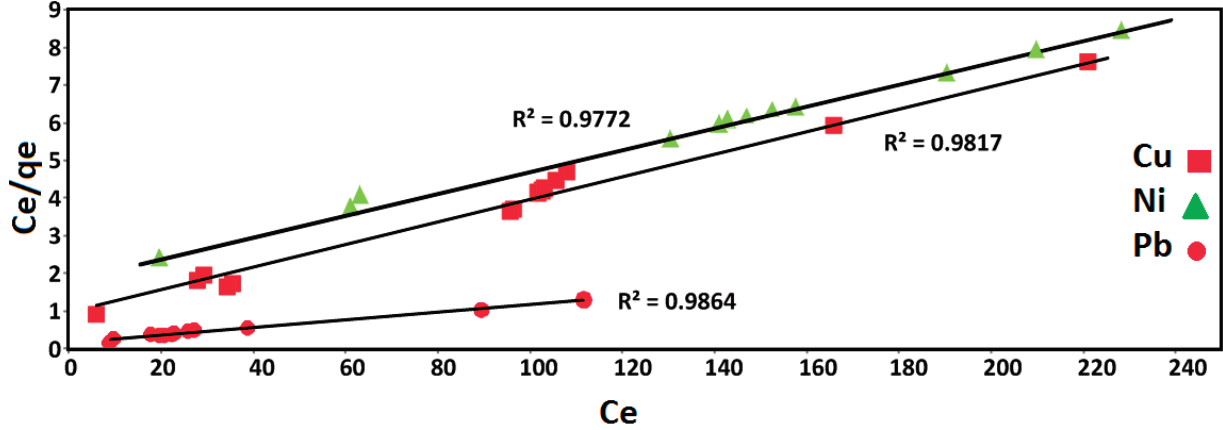
Figure 4. Langmuir isotherm fitting by the Fe Pb(II) removal process.